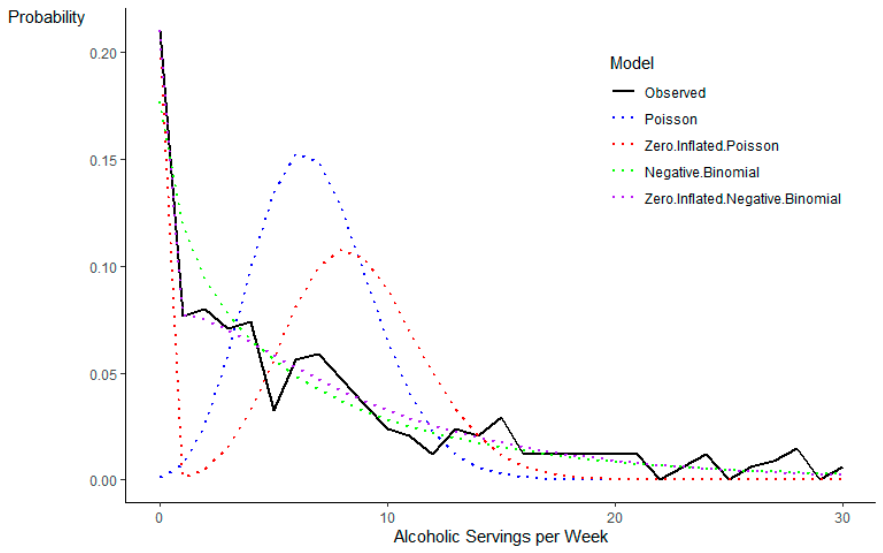
Figure 2. Models for alcohol servings per week.